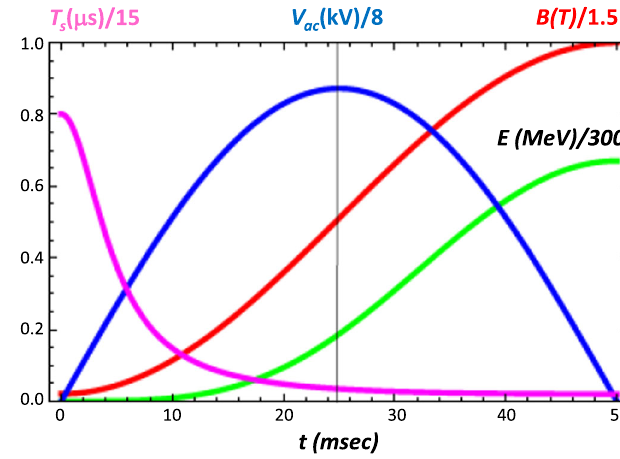
FIG. 8. Temporal evolutions of machine and